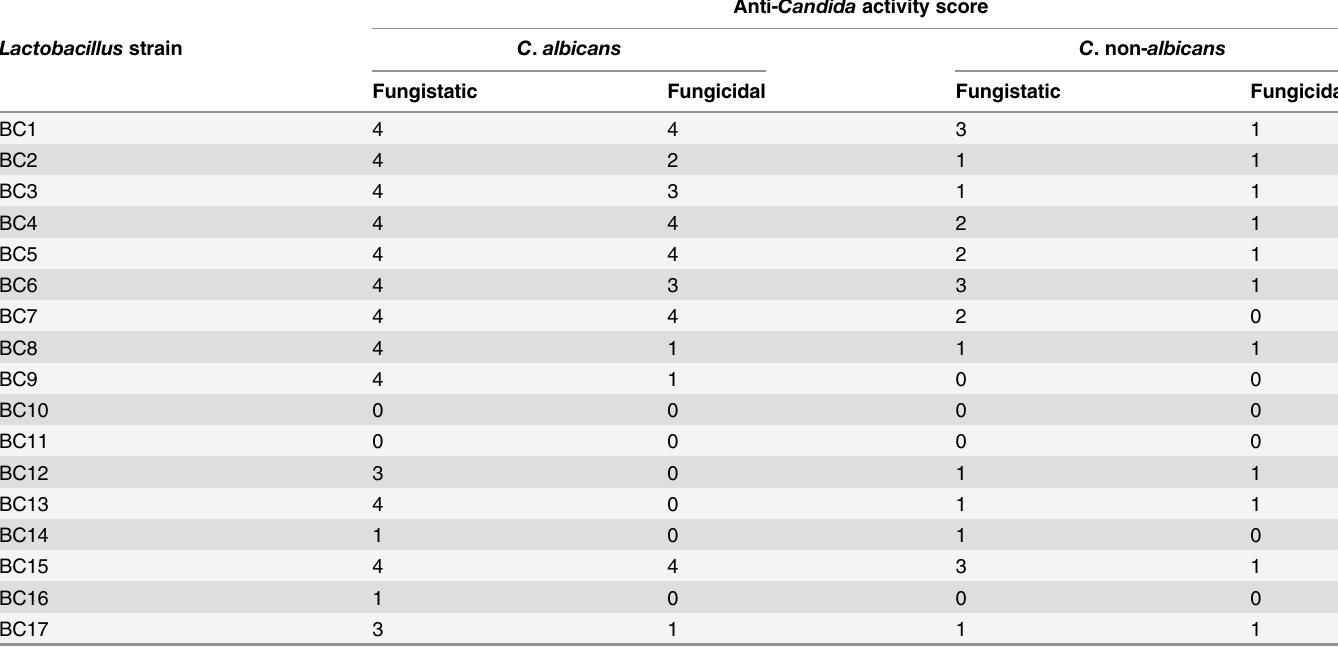
Table 3. Fungistatic and fungicidal activity scores of lactobacilli towards C . albicans and C . non- albicans